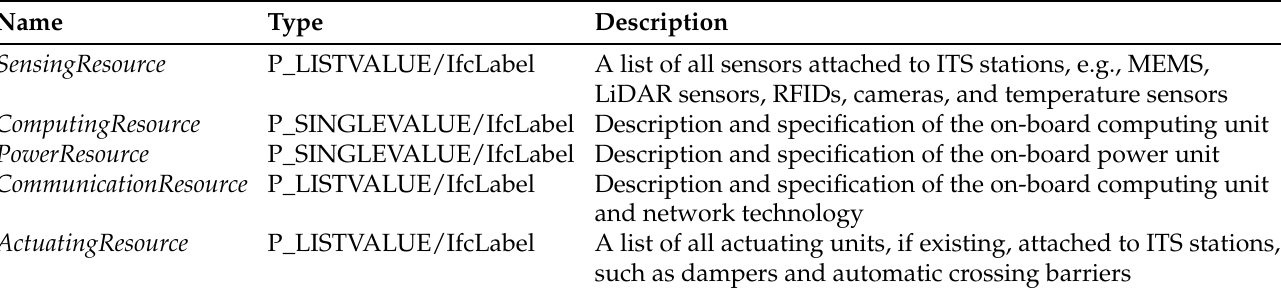
Table 1. Property set Pset_ITSSResources for describing IfcITSStation